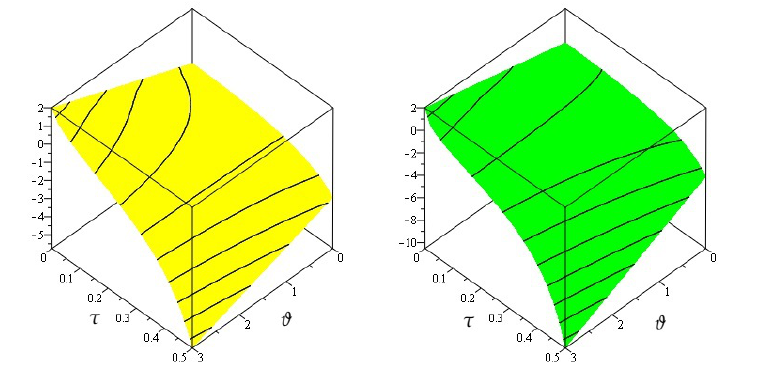
Figure 17. The analytical solutions of ν ( ϑ , ζ , z , τ ) at (cid:36) = 0.6 and 0.4 of Example 4.